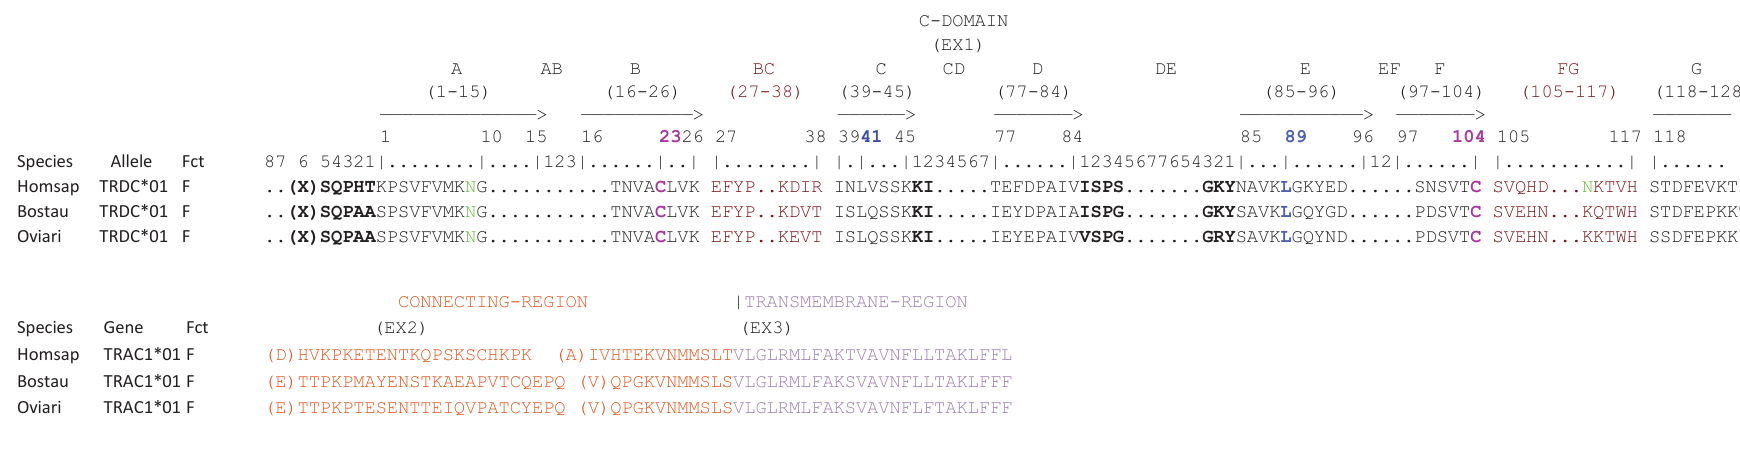
Figure 4. Protein display of the TRDC genes in human (Homsap), bovine (Bostau) and sheep (Oviari). Only alleles *01 are shown. The description of the strands and loops is according to the IMGT unique numbering for C-DOMAIN [29]. The AA between parentheses at the beginning of EX1, EX2 and EX3 corresponds to the first codon resulting from a splicing frame 1 (sf1). (http://www.imgt.org/IMGTeducation/Aide-memoire/_UK/splicing/). Data available in IMGT Repertoire (IG and TR) http://www.imgt.org/IMGTrepertoire/ > Proteins and alleles > Protein displays > C-DOMAIN > TRAC > Human, ibid. Bovine, ibid.